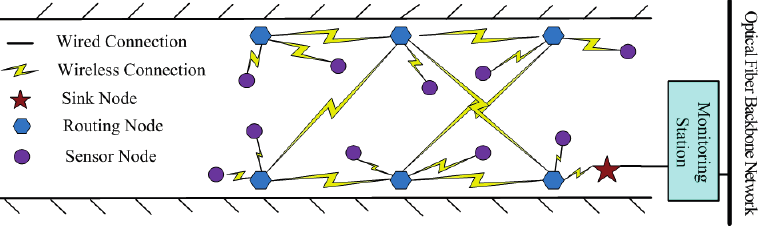
Figure 2. Topology structure of the WSN for underground coal